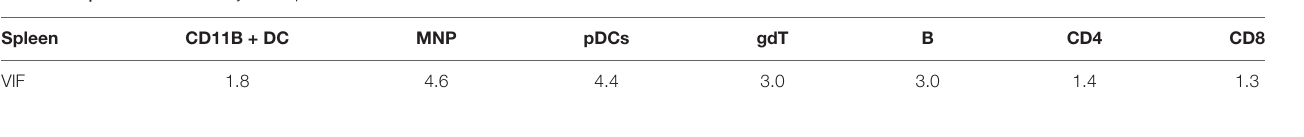
TABLE 2B | Results of VIF analysis in